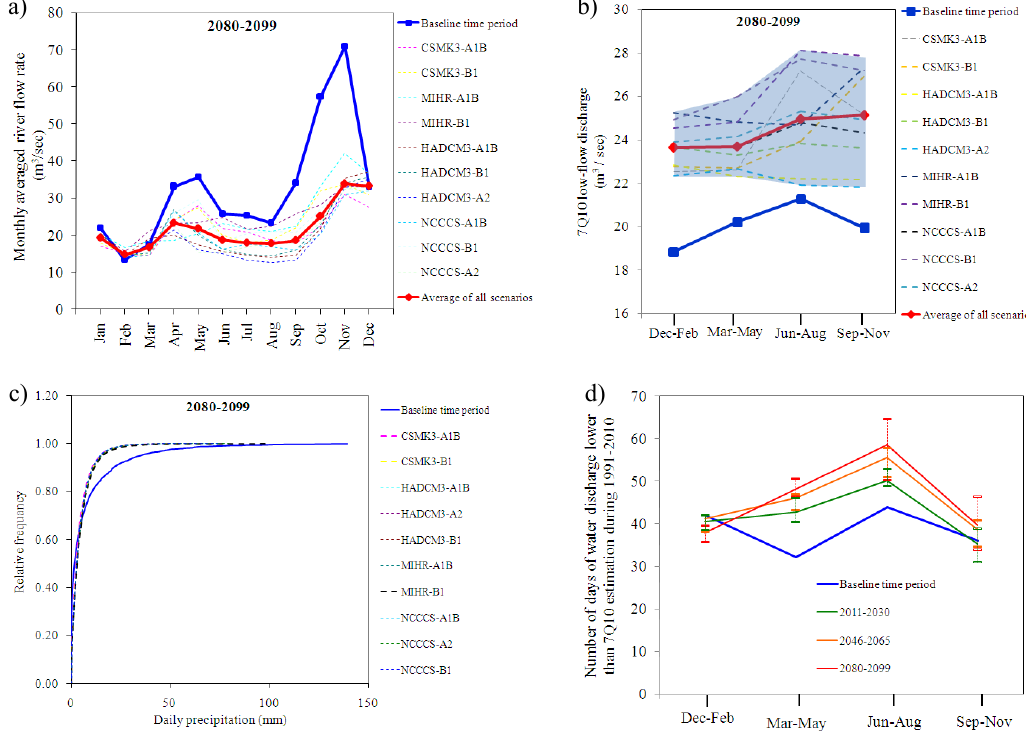
Fig. 9. Results of river discharge predictions for the long-term climate. (a) Changes in monthly average river discharge compared to the baseline time period. (b) 7Q10 low-flow discharge compared to the baseline time period. (c) Relative frequency of daily precipitation compared to the baseline time period. (d) Number of days with river water discharge lower than the 7Q10 estimation for the baseline time period. The whiskers represent the interquartile range for the 25th and 75th percentiles from all 10 scenarios. The solid line represents the average of 10 scenarios.